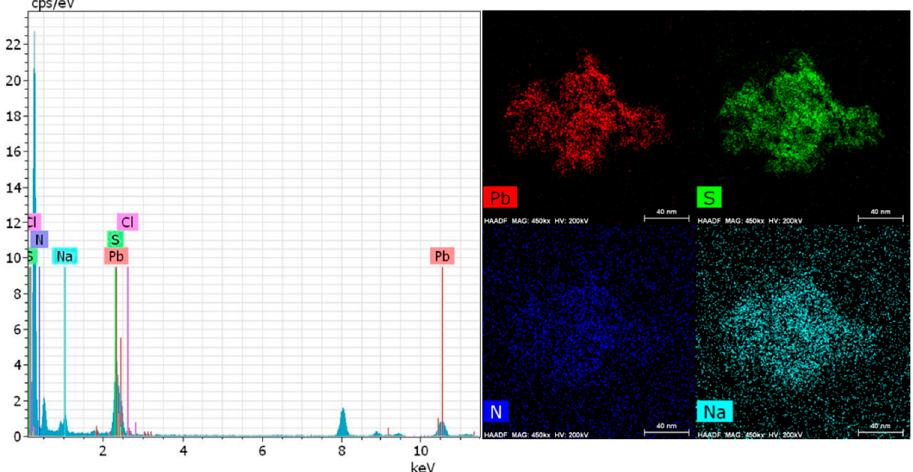
Figure 6. Energy dispersive X-ray spectroscopy (EDS) results of the aggregation-free cysteamine capped PbS quantum dot. The images show the presences of nitrogen (12 mol.%) and sodium (21 mol.%) atoms, indicating that the two ligands were attached to the surface of the PbS quantum dot.